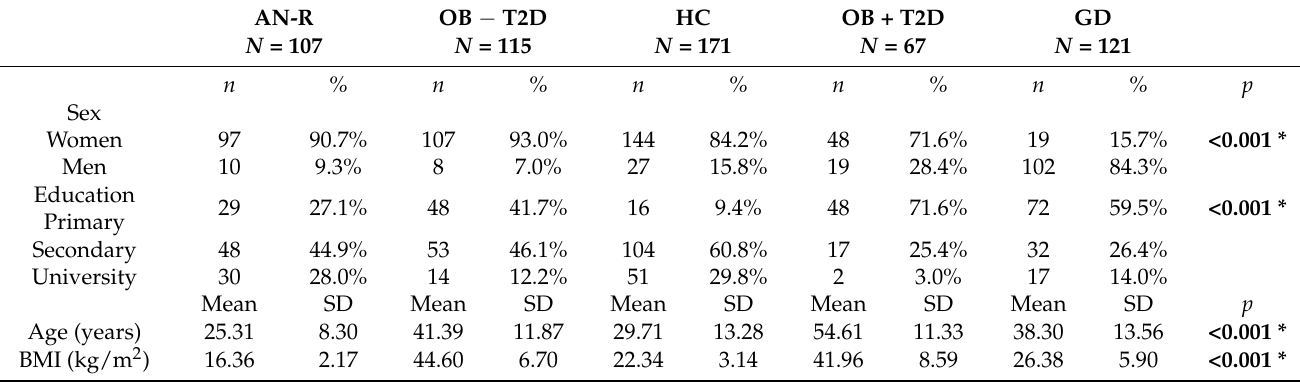
Table 1. Descriptive for the